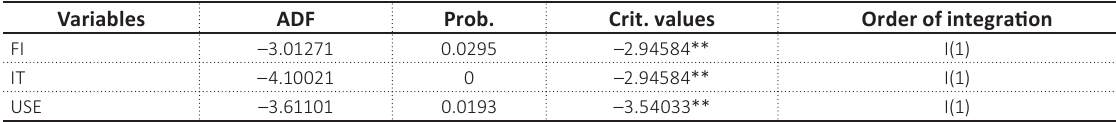
Table 2. ADF test